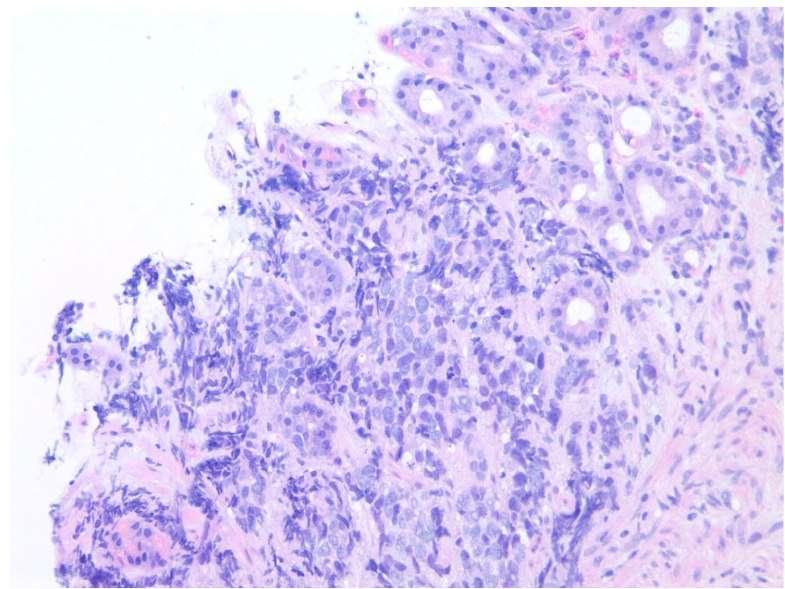
Figure 18. Poorly differentiated carcinoma with nested growth of small cells, with scant cytoplasm, small, oval to elongated nuclei, evenly distributed smudged chromatin, inconspicuous nucleoli, nu- clear molding and brisk mitotic activity consistent with small cell carcinoma seen on on Hematoxy- lin and eosin stain at 200× magnification.